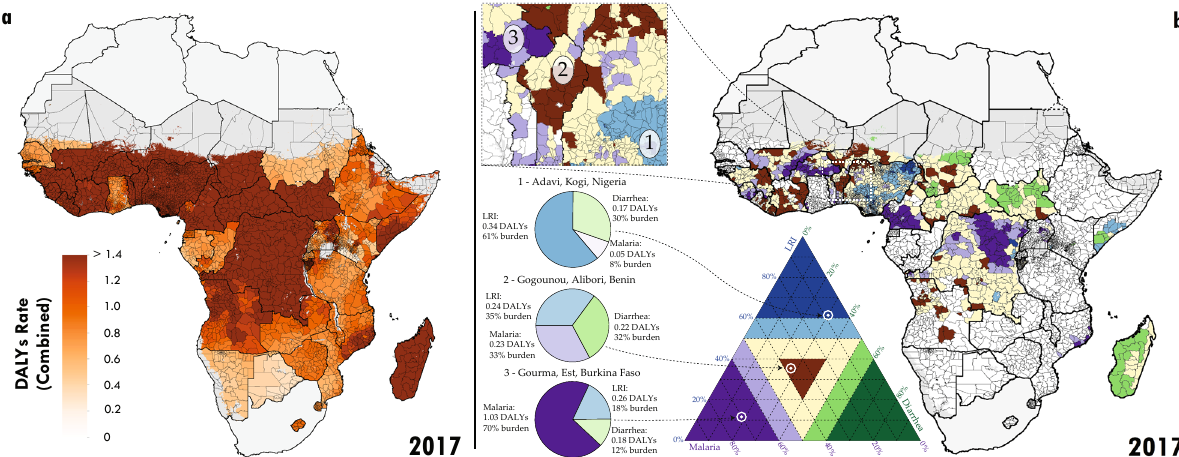
Fig. 2 | Combined disability-adjusted life years (DALYs) in 2017 and decom- position. a Second administrative level estimates of combined DALYs. b For sec- ond administrative units where the combined DALYs per child per year exceeded 0.5 in 2017, the primary component of the local composition of burden is plotted. UnitswherethecombinedDALYswerelessthan0.5areplottedaswhite.Unitswith dark purple have greater than 60% of their combined burden attributable to malaria (e.g., areasofBurkina Faso). Units with dark blue have greater than60% of their combined burden attributable to LRIs (e.g., areas of Nigeria). Units with dark green have greater than 60% of their combined burden attributable to diarrhoea